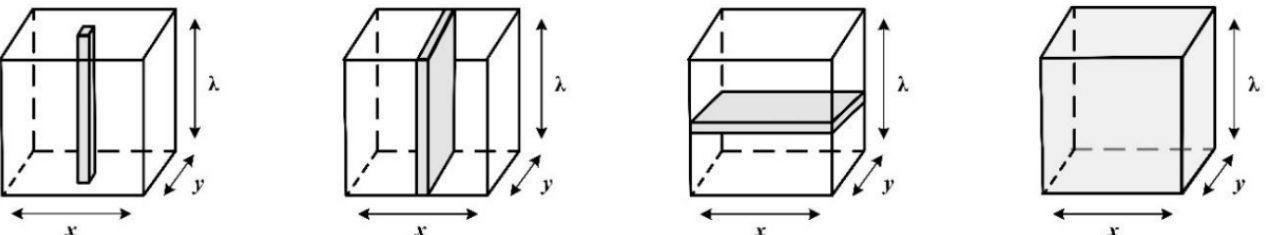
Figure 4. HSI acquisition method [26].